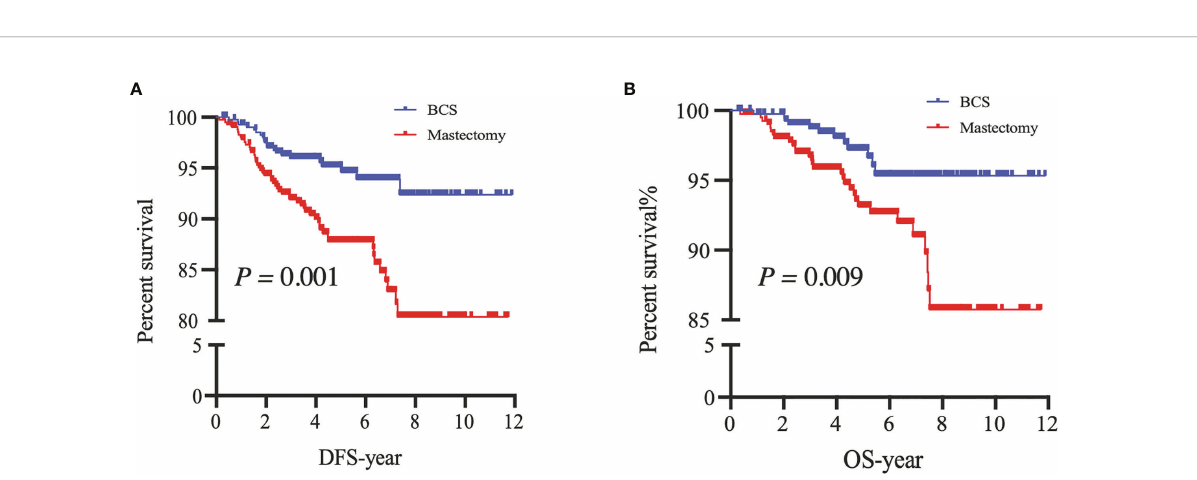
FIGURE 4 | After propensity score matching, disease-free survival (DFS) (A) and overall survival (OS) (B) of patients between breast-conserving surgery (BCS) and mastectomy alone (Mastectomy).